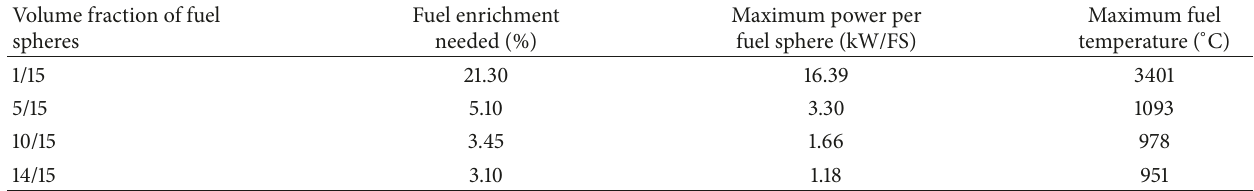
Table 2: The key physical parameters of typical volume fractions of fuel spheres in the initial